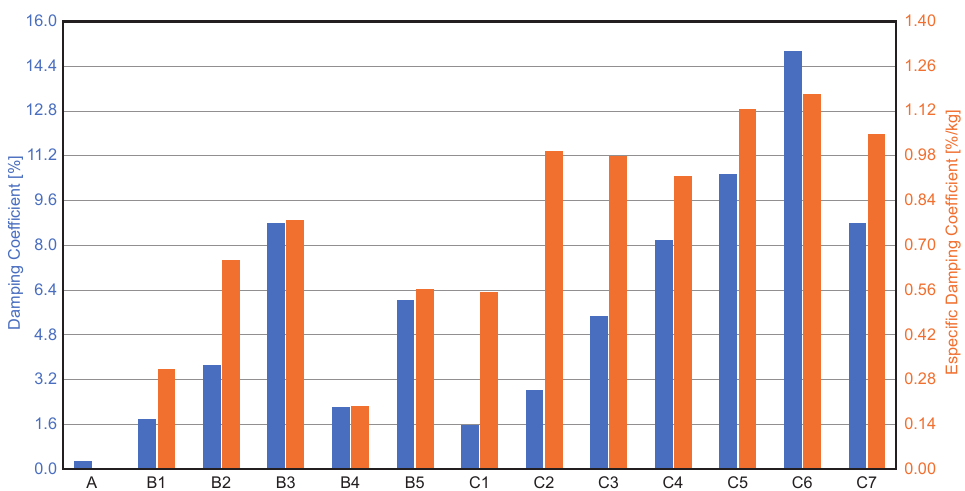
Figure 7. Damping coefficients of the second mode of vibration for the different configurations.